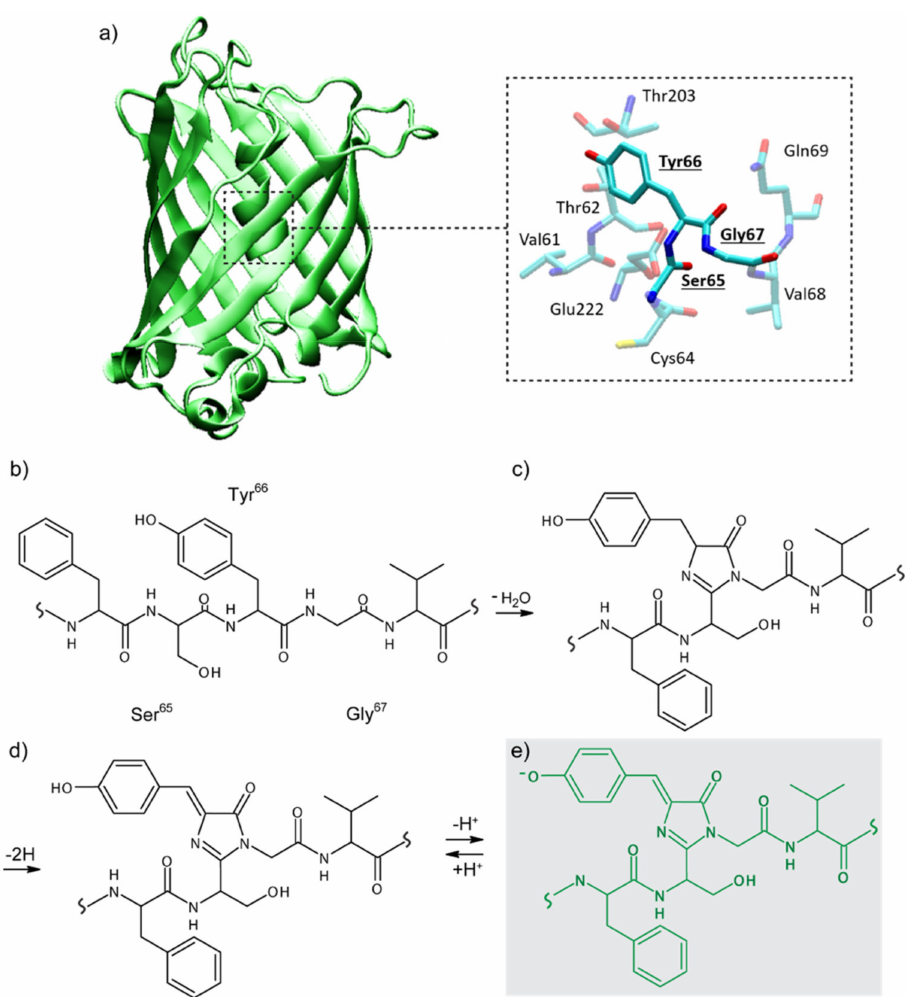
Figure 10. GFP structure and cyclization : ( a ) Structure of the GFP highlighting the β -barrell (green stripes) embedding the distorted α -helix. The chromophore, in the middle of the α -helix, is reported in the zoom. ( b – d ) Cyclization of the GFP chromophore starting from ( b ) the starting molecule which ( c ) undergoes a dehydration and ( d ) an oxidation process. The state plotted in (d) is the ground state or the “protonated” form of the chromophore. Upon excitation, the molecule brings itself into the so-called “anionic” state, plotted in ( e